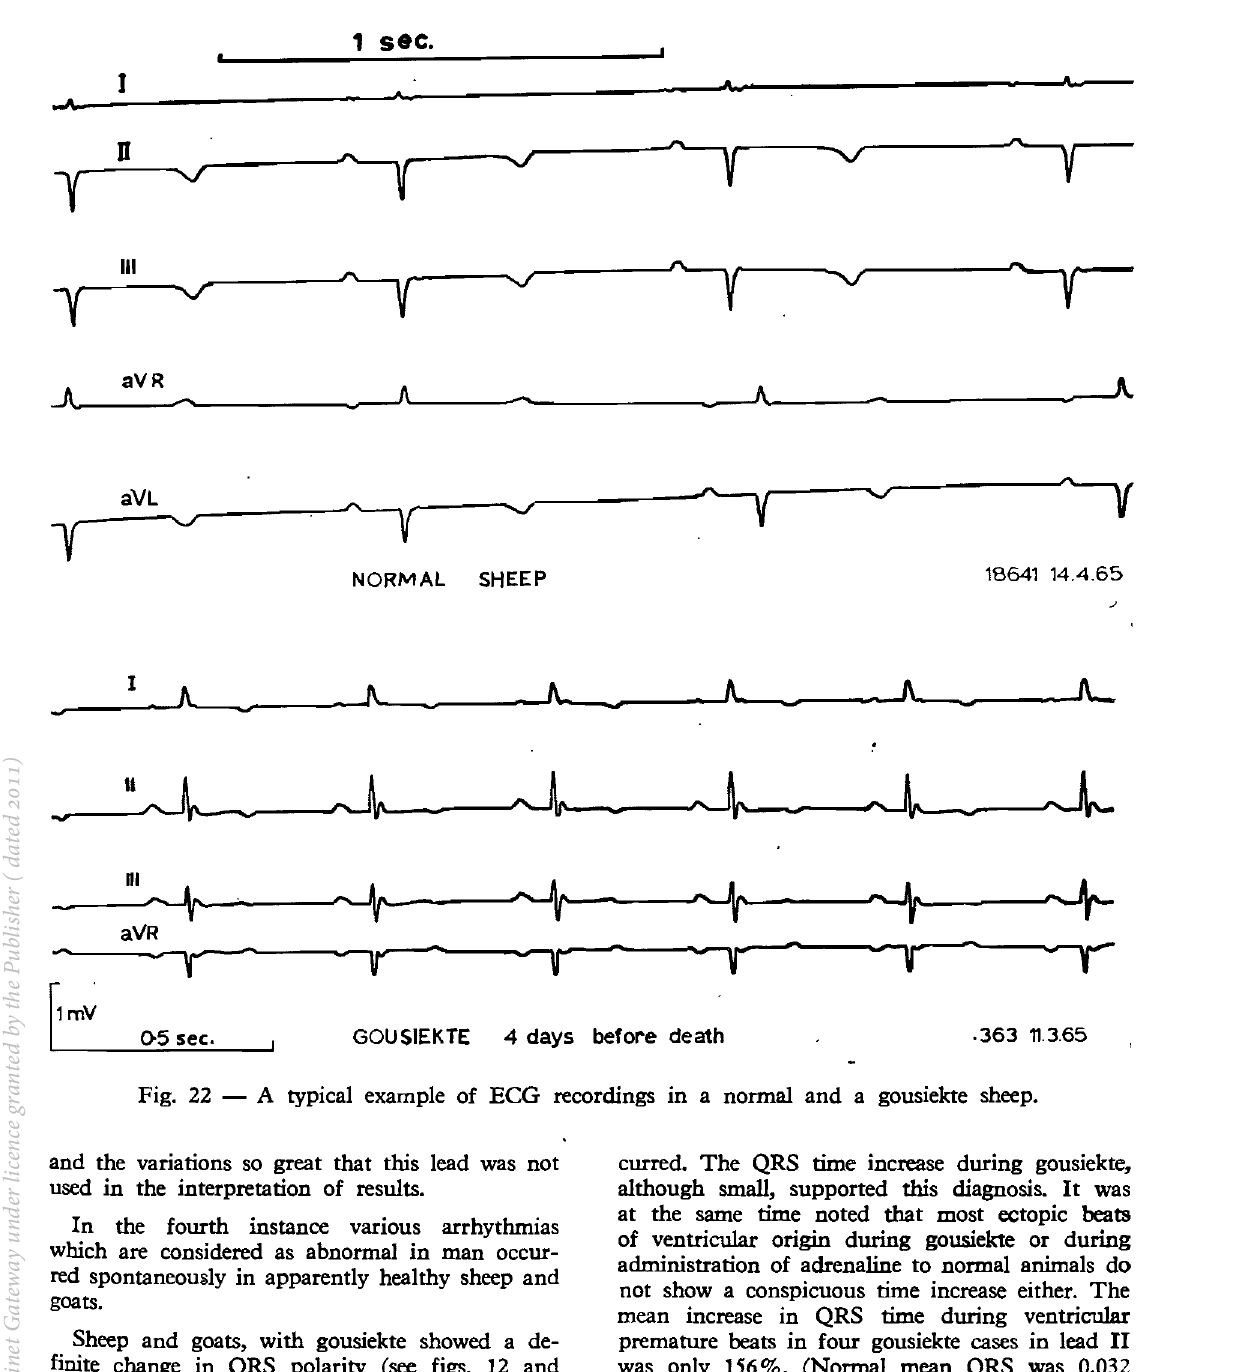
A typical example of ECG recordings in a normal and a gousiekte